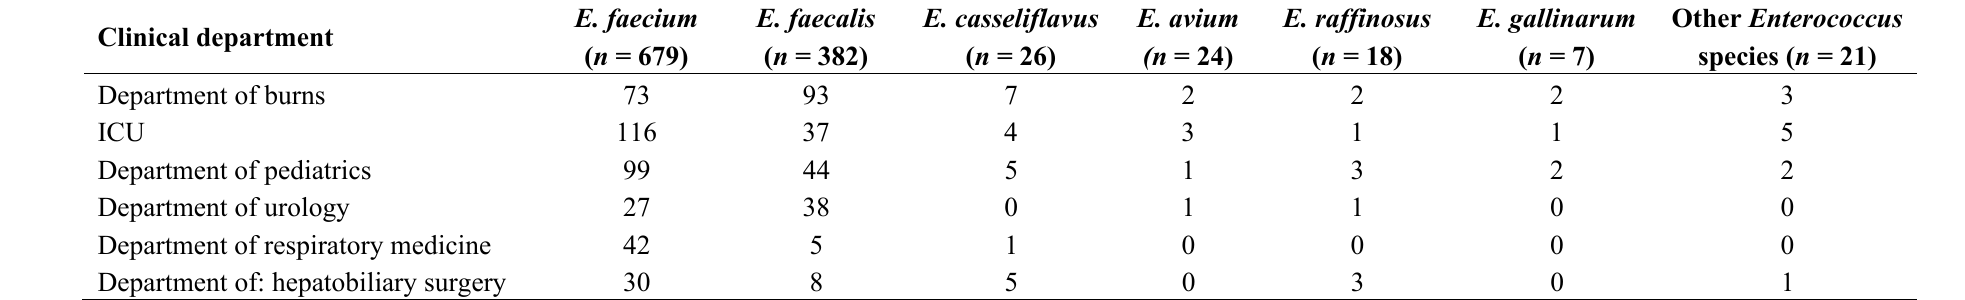
Table 4. Distribution of 1157 Enterococcus species isolated from various clinical